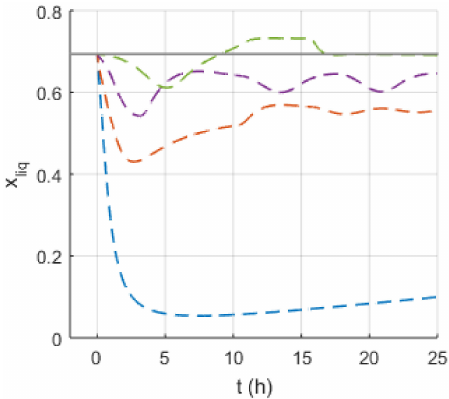
Figure 15. Behavior of liquid fraction of monomer in scenarios S-1 and S-2 with Model 3. Make-up flow: ( ) no flow; ( ) 50% of normal flow; ( ) 90% of normal flow; ( ) 99% of normal flow; ( )